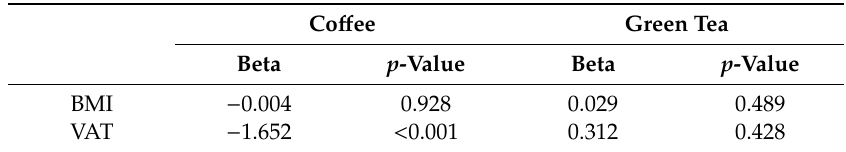
Table 3. Multiple linear regressions between each categorized consumption of co ff ee and green tea and BMI and VAT. Co ff ee Green Tea Beta p -Value Beta p -Value BMI − 0.004 0.928 0.029 0.489 VAT − 1.652 < 0.001 0.312 0.428